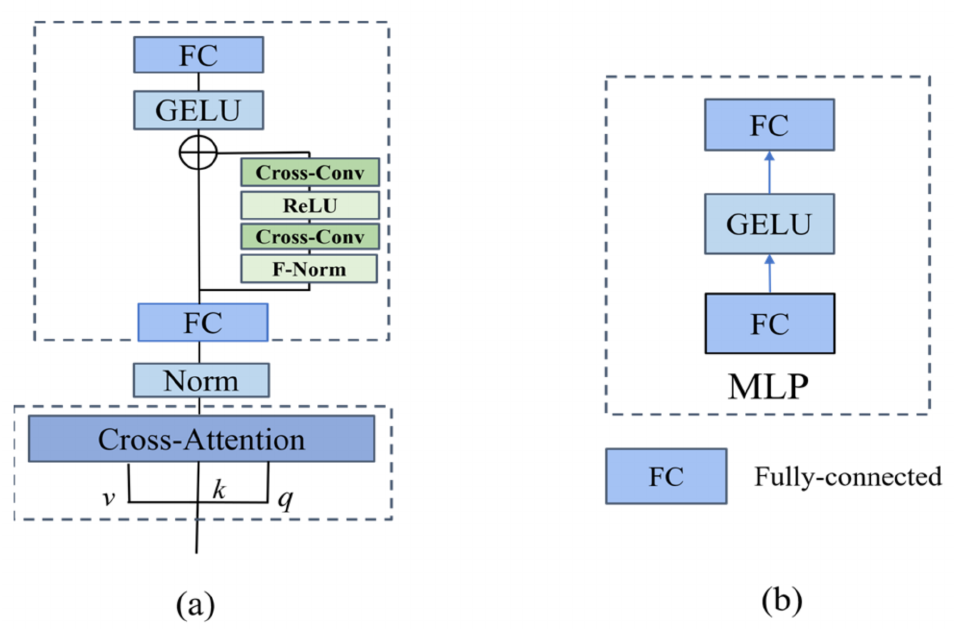
Figure 8. ( a ) The structure of cross-detail module, FC stands for fully-connected, Norm stands for Layer Normalization, and k means keys , v means values , and q means queries. ( b ) The structure of multi-layer perceptron (MLP). GELU stands for Gaussian Error Linear Unit, which is an activation function. F-Norm stands for feature normalization. ReLU stands for rectified linear